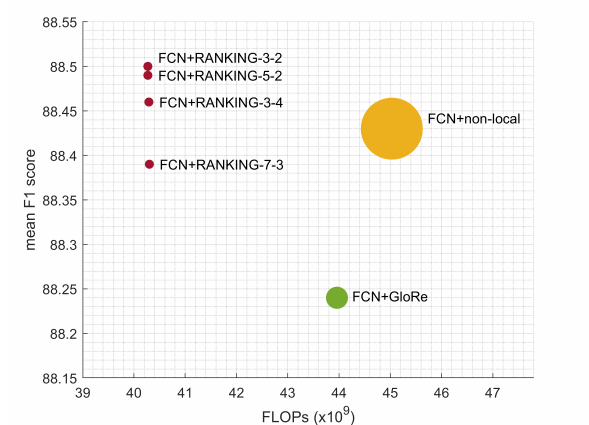
Figure 3. Ablation study on the Vaihingen dataset. Red circles indicate our proposed FCN+RANKING network, and different versions are considered here. Green and yellow circles correspond to FCN+GloRe and FCN+non-local, respectively. The size of circles refers to the memory consumption of each model. Notably, models located at the upper left corner are high-performance and computationally